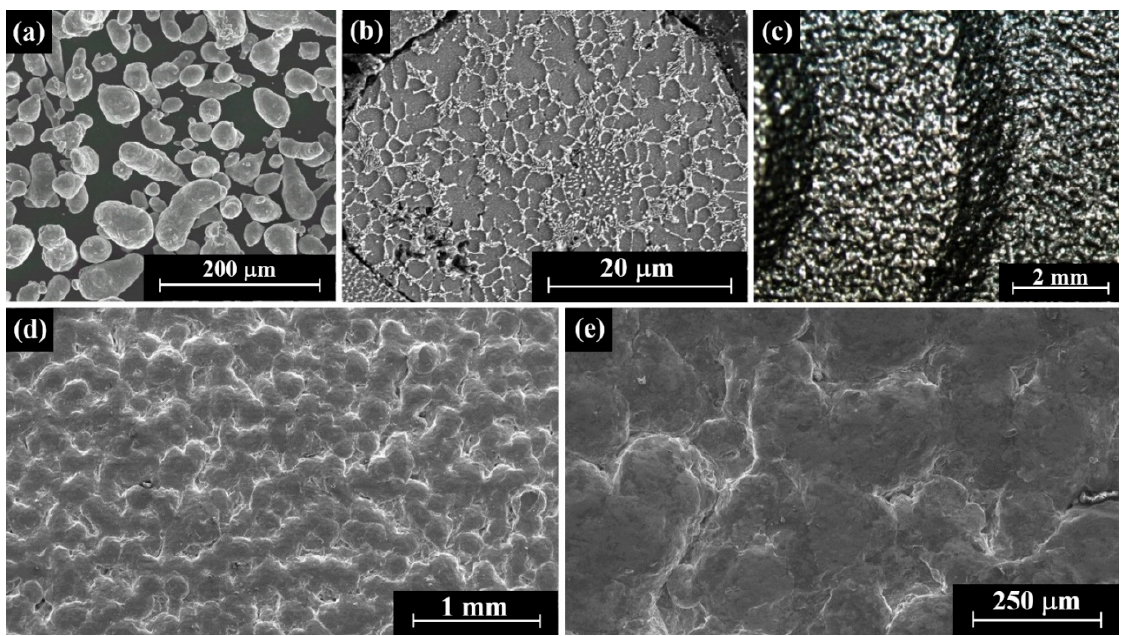
Figure 2. The representative surface of an as-printed AM-LPBF AlSi10Mg disk-shaped reference specimen (obverse): ( a ) AlSi10Mg feedstock, typical powder particles (SEM); ( b ) AlSi10Mg characteristic particle’s cross-section; ( c ) a general view of the as-printed disk-shaped specimen (multi-focal light microscope); and ( d , e ) higher magnifications of the disk-shaped specimen surface (SEM).